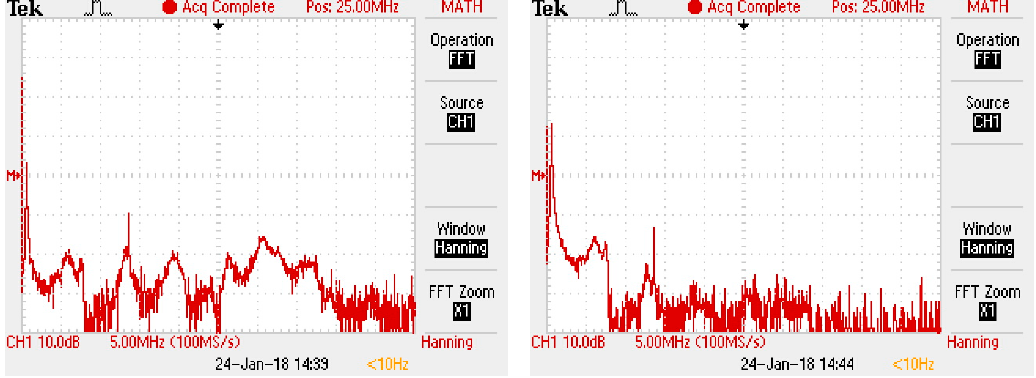
Figure 18. FFT of PD signal without filter ( left ); FFT of PD signal with filter ( right ).